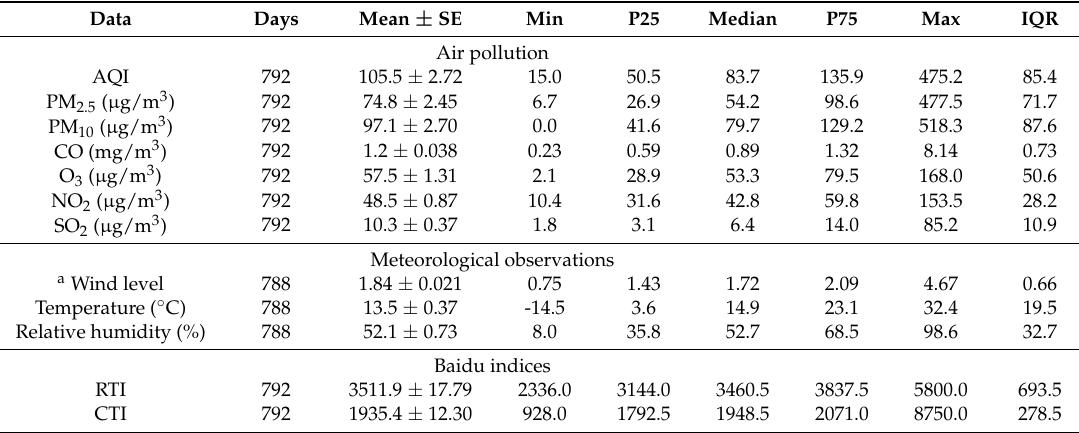
Table 3. Summary statistics of air pollution data, meteorological observations, and Baidu searches in Beijing (1 March 2015–30 April 2017).